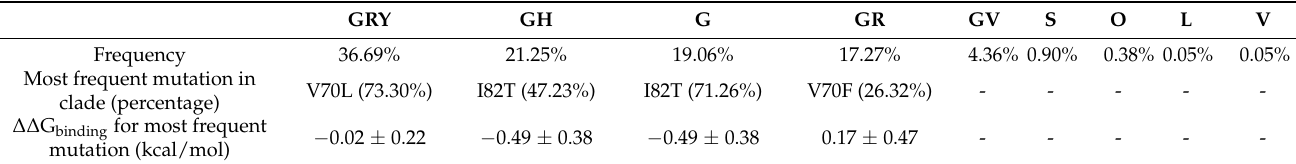
Table 5. ∆∆ G binding average values for the most frequent mutation found in each clade. Table 5. ΔΔG binding average values for the most frequent mutation found in each clade.